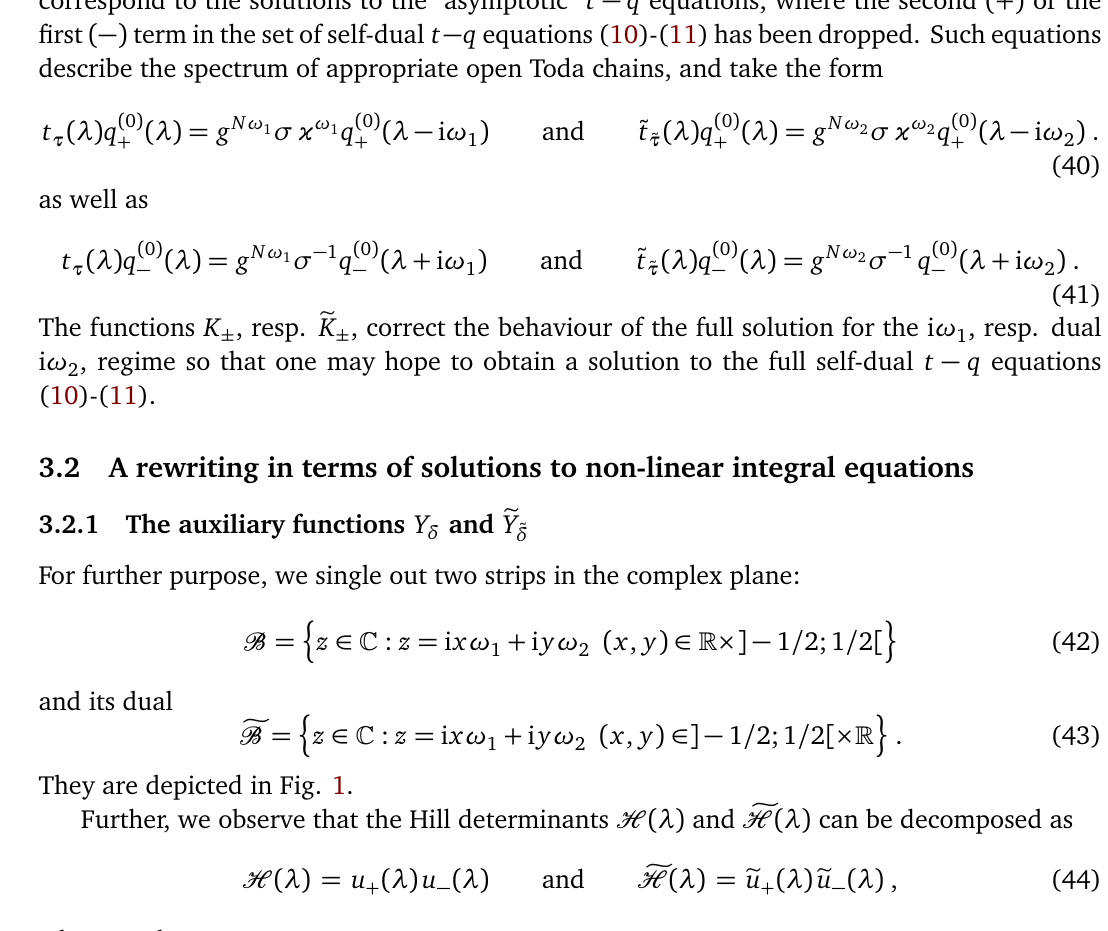
f B and the curves C (cid:14) and